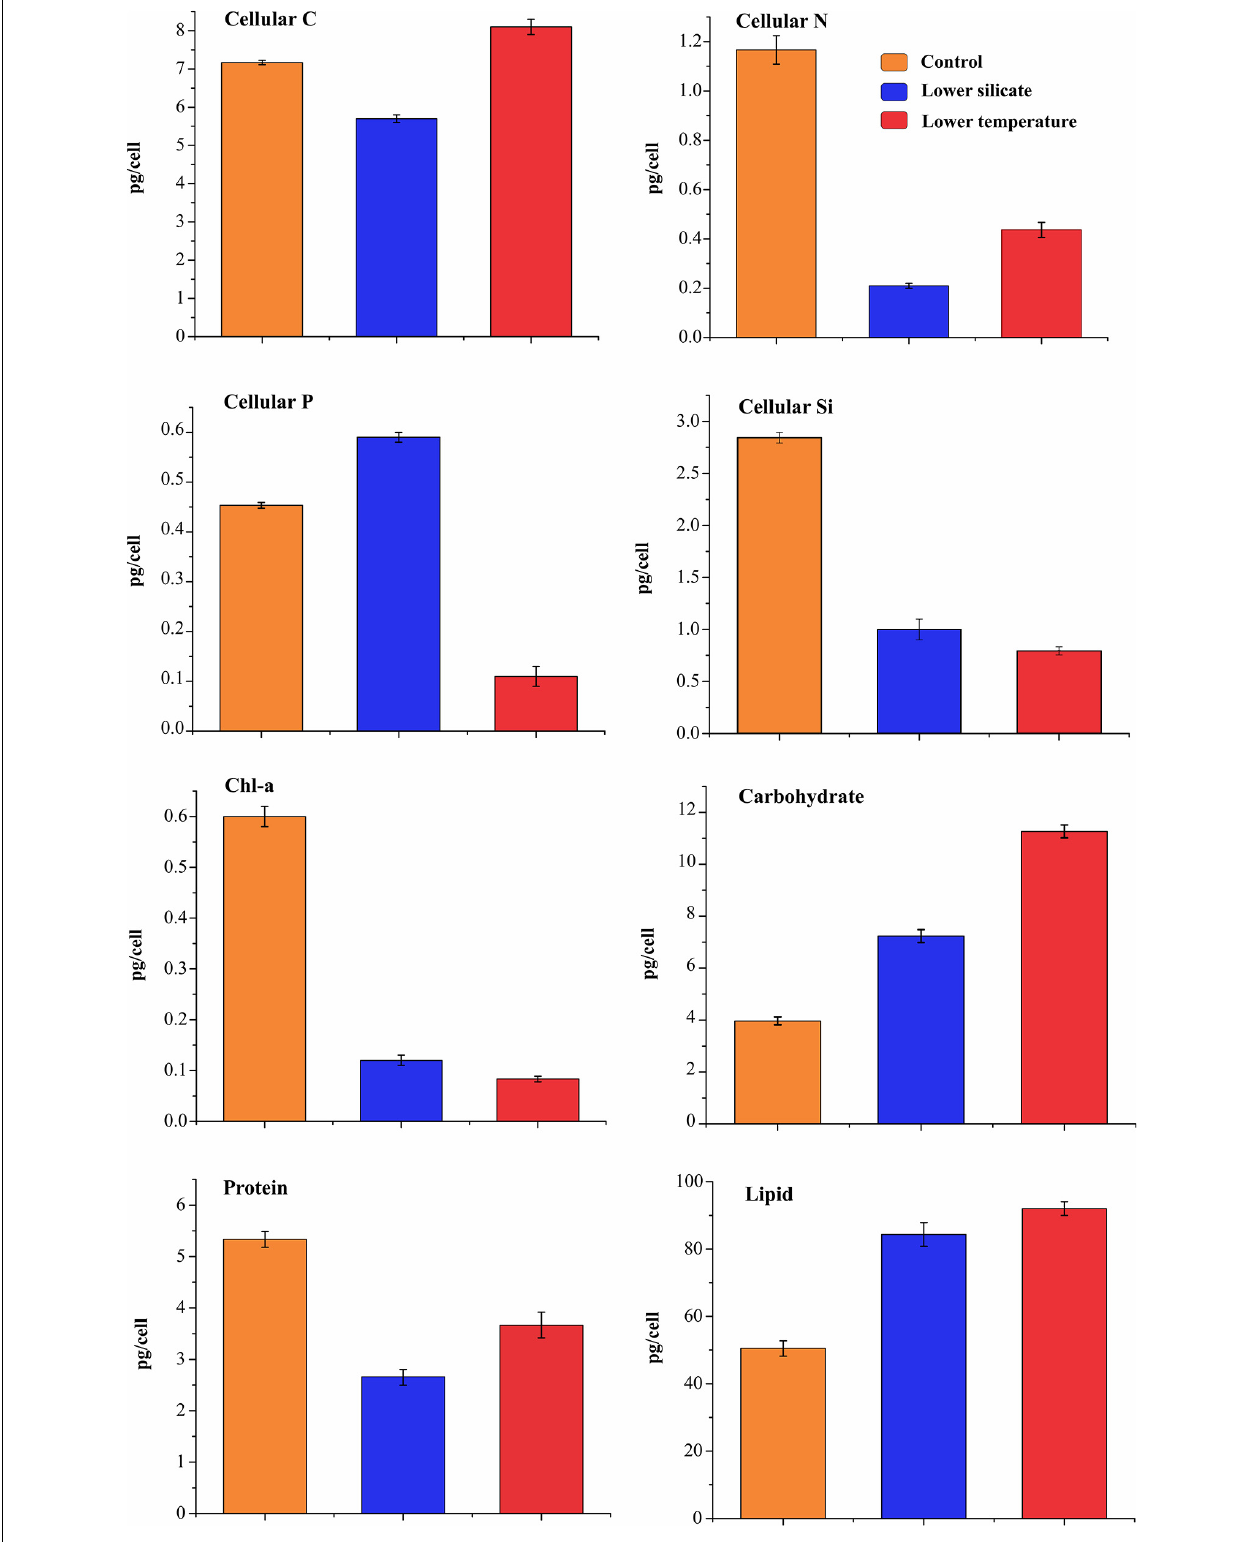
FIGURE 2 | Cellular elements and macromolecular component composition in S. dohrnii grown under control, silicate-, and temperature-limited conditions. The error bars represent the standard deviation of the means ( n = 3).